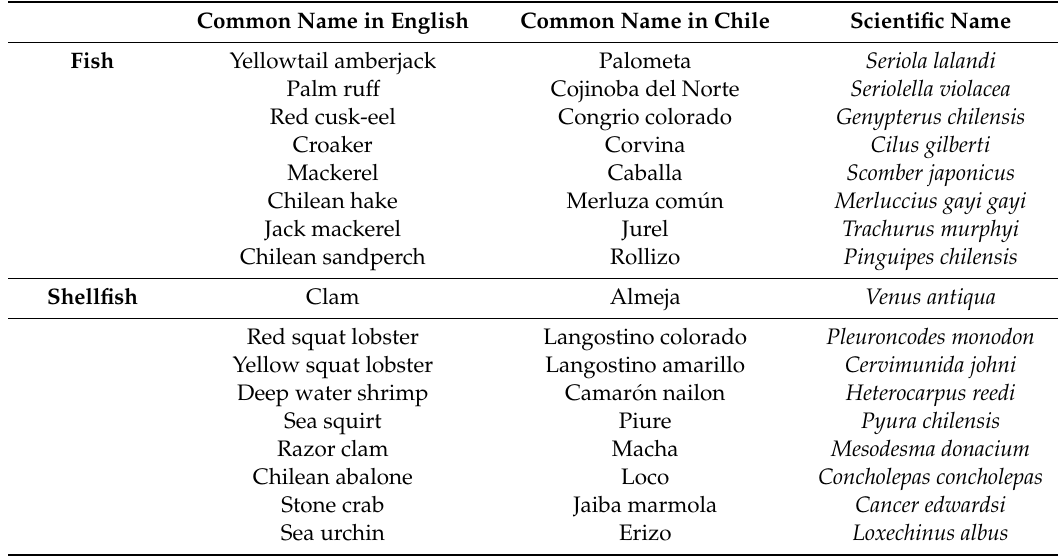
Table 1. Fish and shellfish species analyzed in this